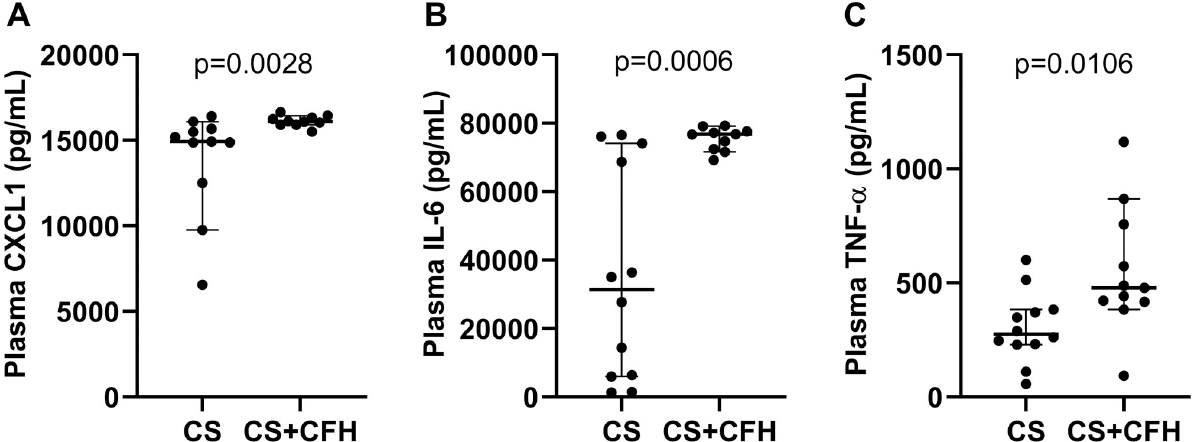
Fig 2. Intravenous CFH augments systemic cytokine increases in murine sepsis. Plasma cytokines were measured 24 hours after CS or CS+CFH treatment (n = 11–12). (A) CXCL1 (p = 0.0028), (B) IL-6 (p = 0.0006) and (C) TNF- α (p = 0.0106) were higher in CS+CFH versus CS alone.